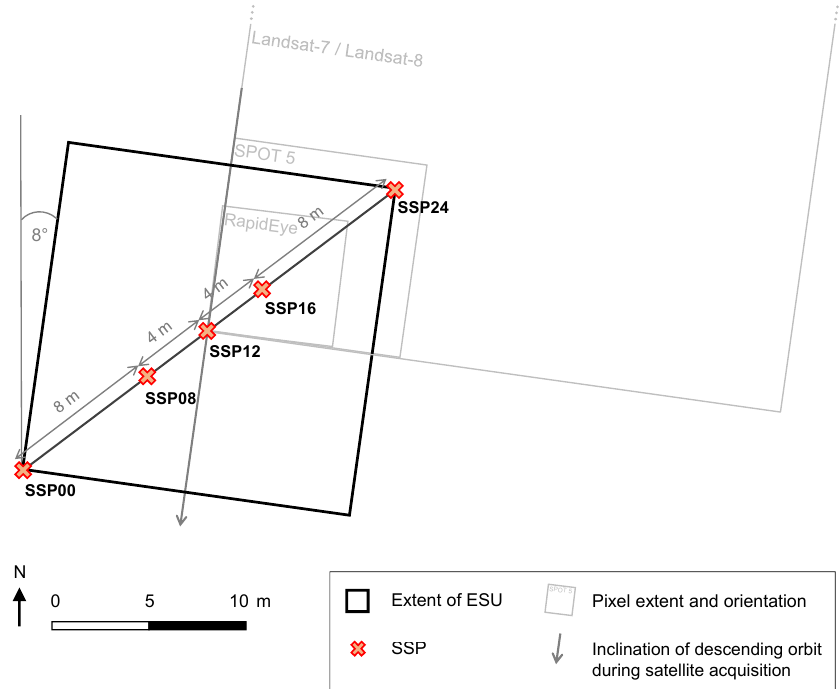
Figure 2. Design of elementary sampling units (ESUs). Each ESU contains five secondary sampling points (SSPs). The azimuthal orientation of the ESUs was chosen according to the inclination of the SPOT 5 and Landsat-7 and -8 descending orbits. The figure illustrates the pixel size of images from various satellite sensors in comparison to the size of ESUs. The case with the smallest spatial coincidence between pixels and the ESU is